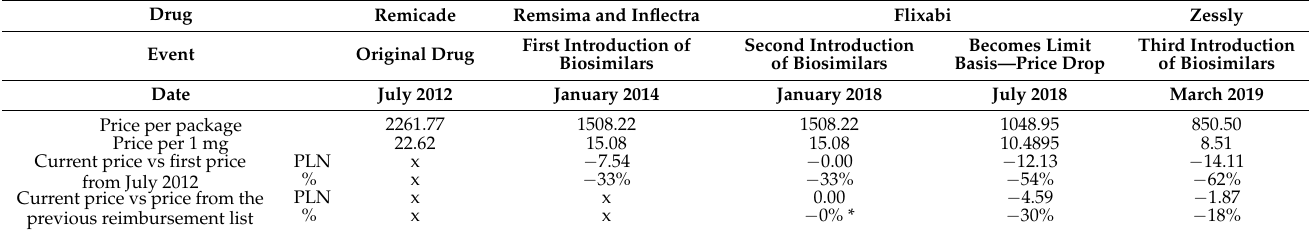
Table 3. Gross wholesale price changes between July 2012 and March 2020 of inliximab after biosimilar